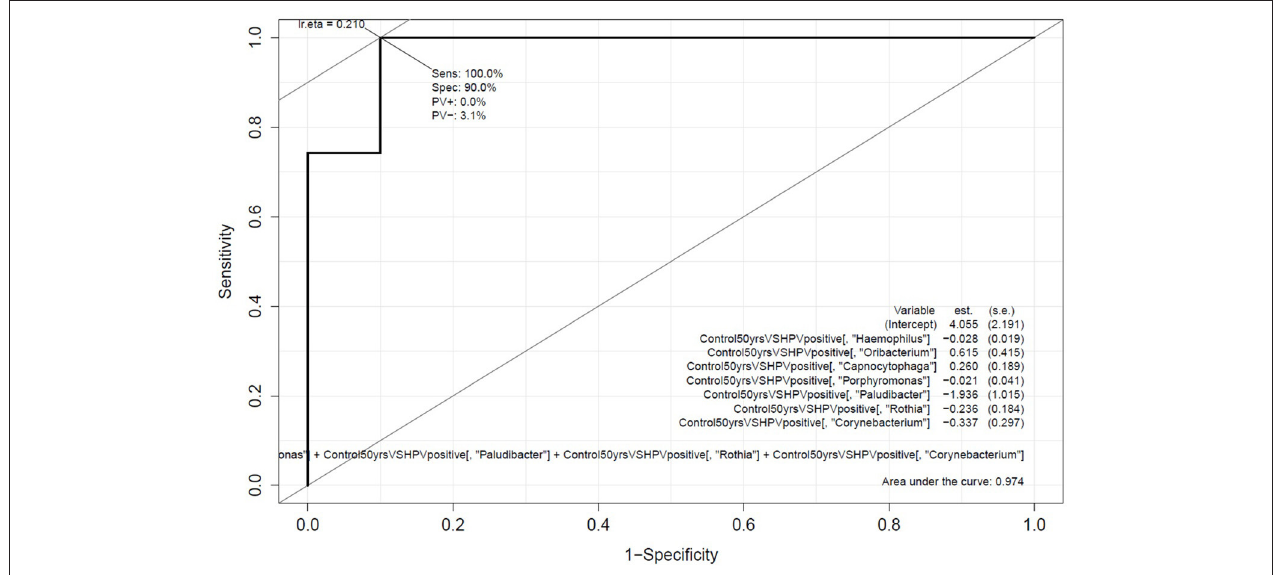
FIGURE 3 | Performance of the oral microbiome panel in predicting oral cavity and oropharyngeal cancers. Carstensen’s multivariate receiver-operating characteristics curve based on the abundance of Rothia , Haemophilus , Corynebacterium , Paludibacter , Porphyromonas , Oribacterium, and Capnocytophaga ; comparing normal healthy controls (above 50 years of age, n = 10) with oral cavity and oropharyngeal cancer patients ( n =